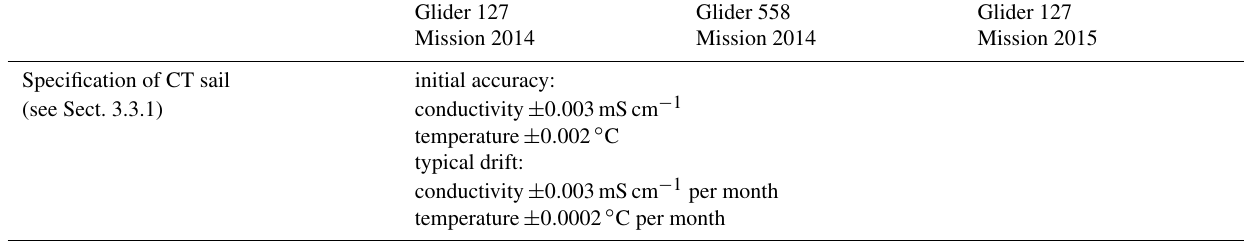
Table 4. Summary of the data quality and effects of the different steps of the data processing for the three individual data sets (glider 127 mission 2014, glider 558 mission 2014 and glider 127 mission 2015). References to the specific steps of the data processing are given in the left